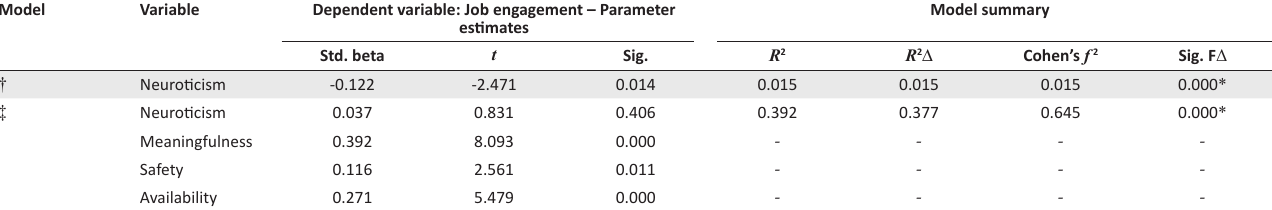
TABLE 9 : Hierarchical multiple regression analyses testing neuroticism and psychological conditions constructs in the prediction of job engagement.